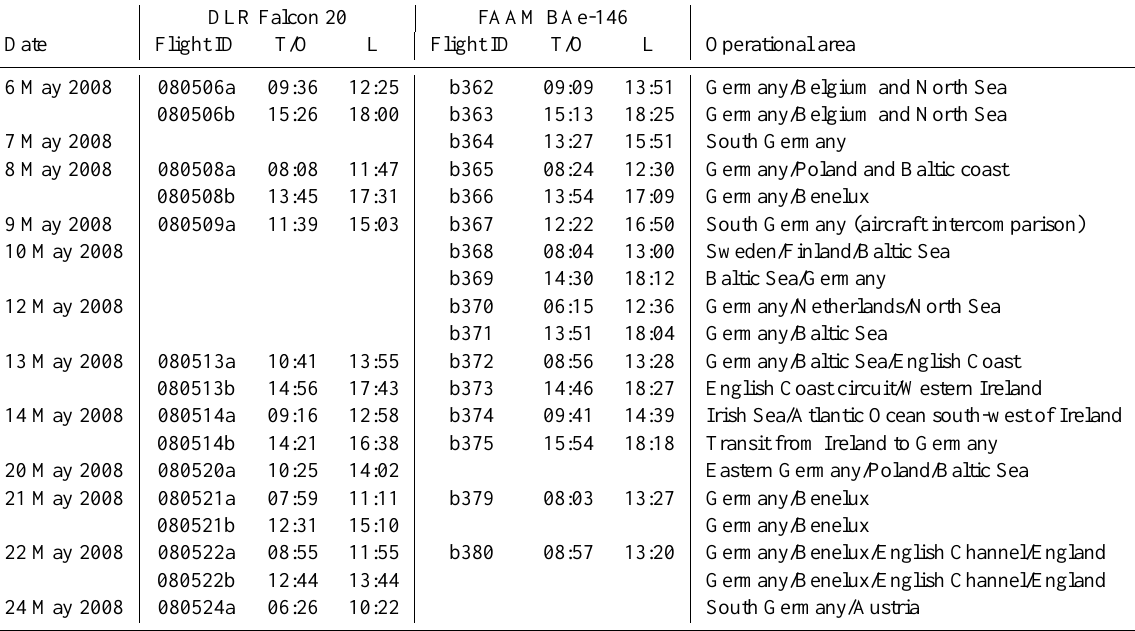
Table 1. Flight summary of DLR Falcon 20 and FAAM BAe-146 during the EUCAARI-LONGREX campaign containing take off time (T/O) and landing time (L) of the flights at local time (LT) and operational area. DLR Falcon